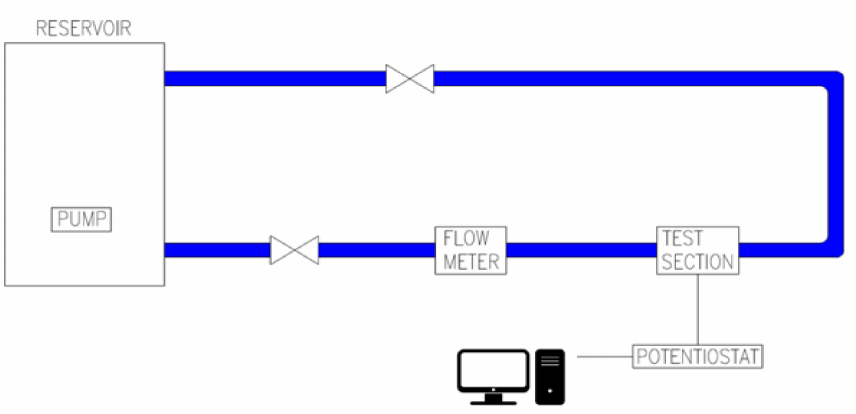
Figure 2. Flow loop for investigating corrosion using LPR method.